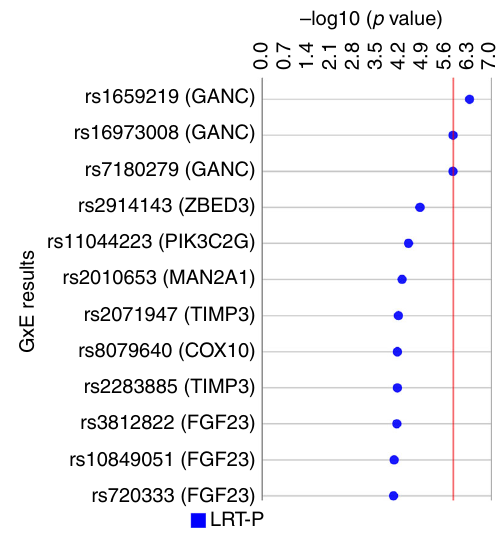
Fig. 3 SNP- Alcohol 30-Day Frequency interaction results. SNP-environment analysis was performed for 33,622 SNPs and 2044 samples (390 cases, 1654 controls) using logistic regression in PLATO. This Synthesis View 58 plot denotes the SNP (nearest gene) on the left and the track to the right displays the – log10 of the uncorrected LRT p value. The red line denotes the Bonferroni threshold for corrected signi fi cance (uncorrected LRT p: 1.49 × 10 − 6 ; α = 0.05, 33,622 tests)